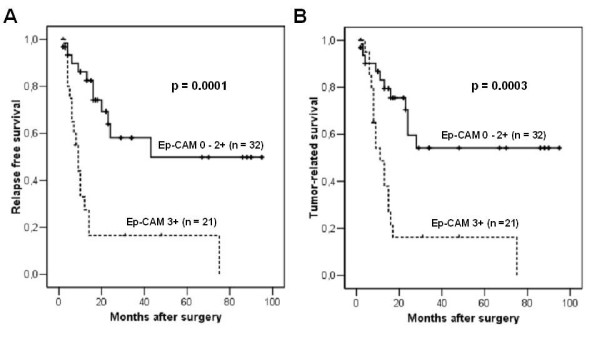
Prognostic impact of Ep-CAM. Kaplan-Meier curves for relapse-free (A) and overall survival (B) calculated from 53 patients with esophageal SCC.